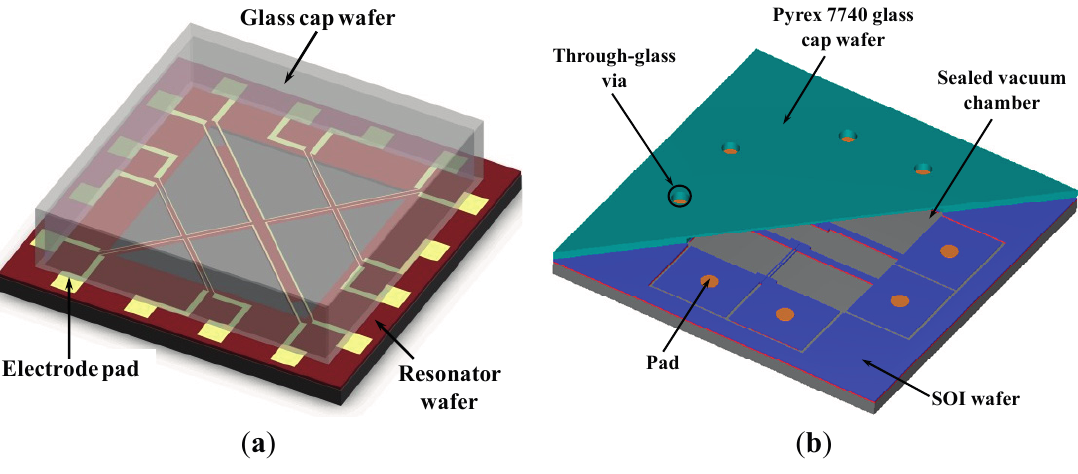
Figure 1. The basic structure diagrams of two wafer-level vacuum packaging